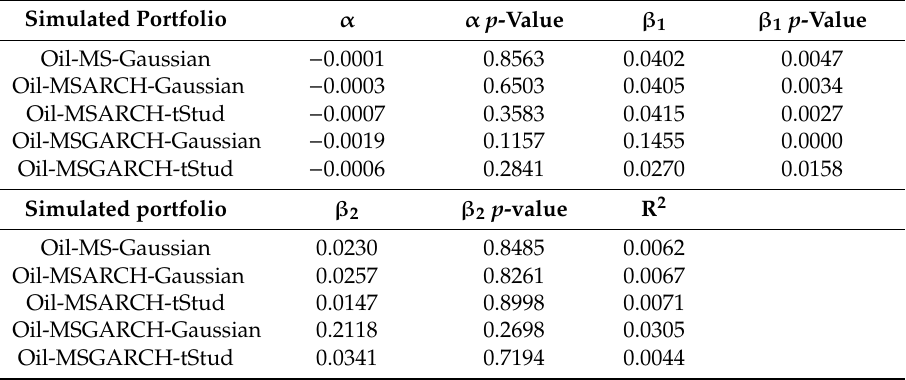
Table 10. Attribution and market timing test of the five simulated portfolios in the NATGAS market. Simulated Portfolio α α p -Value β 1 β 1 p -Value Oil-MS-Gaussian − 0.0001 0.8563 0.0402 0.0047 Oil-MSARCH-Gaussian − 0.0003 0.6503 0.0405 0.0034 Oil-MSARCH-tStud − 0.0007 0.3583 0.0415 0.0027 Oil-MSGARCH-Gaussian − 0.0019 0.1157 0.1455 0.0000 Oil-MSGARCH-tStud − 0.0006 0.2841 0.0270 0.0158 Simulated portfolio β 2 β 2 p -value R 2 Oil-MS-Gaussian 0.0230 0.8485 0.0062 Oil-MSARCH-Gaussian 0.0257 0.8261 0.0067 Oil-MSARCH-tStud 0.0147 0.8998 0.0071 Oil-MSGARCH-Gaussian 0.2118 0.2698